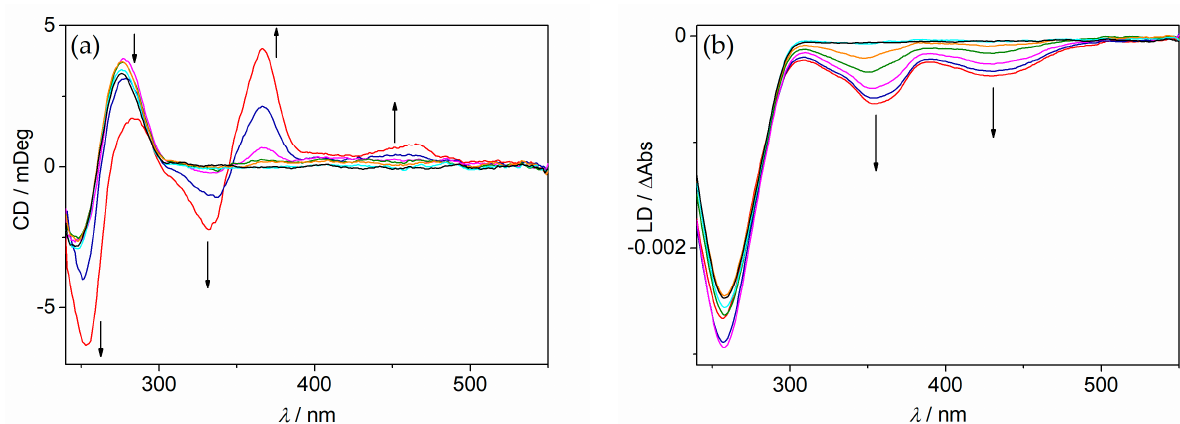
Figure 3. CD spectra ( a ) and LD spectra ( b ) of ct DNA (c DNA = 20 µM) in the absence and presence of 2 at LDR = 0 (black), 0.05 (cyan), 0.2 (orange), 0.5 (green), 1.0 (magenta), 1.5 (blue), and 2.0 (red) in a BPE buffer solution (10 mM, pH 7.0; with 5% v / v DMSO). The arrows indicate the changes in absorption with increasing LDR .